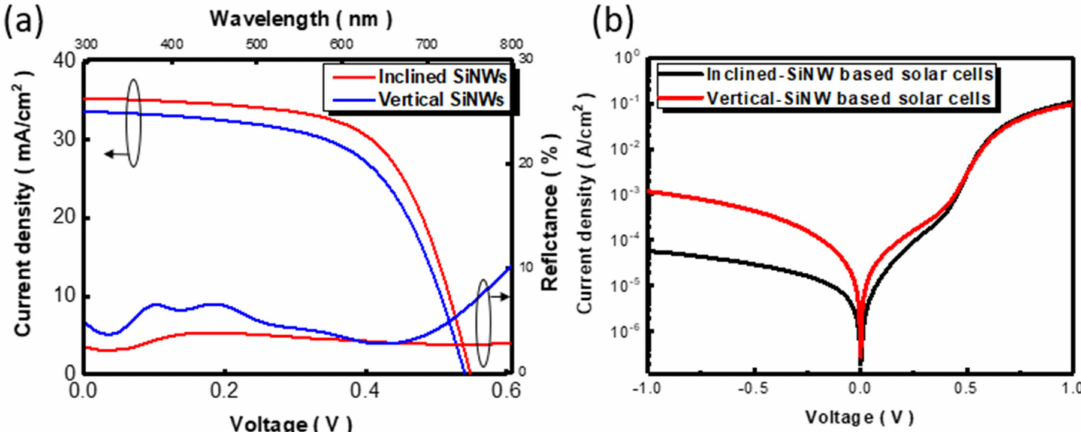
Figure 8. ( a ) Photovoltaic performance and light-reflection characteristics of two different hybrid solar cells. ( b ) Dark-current examinations of inclined-SiNW and vertical-SiNW-based hybrid solar cells,